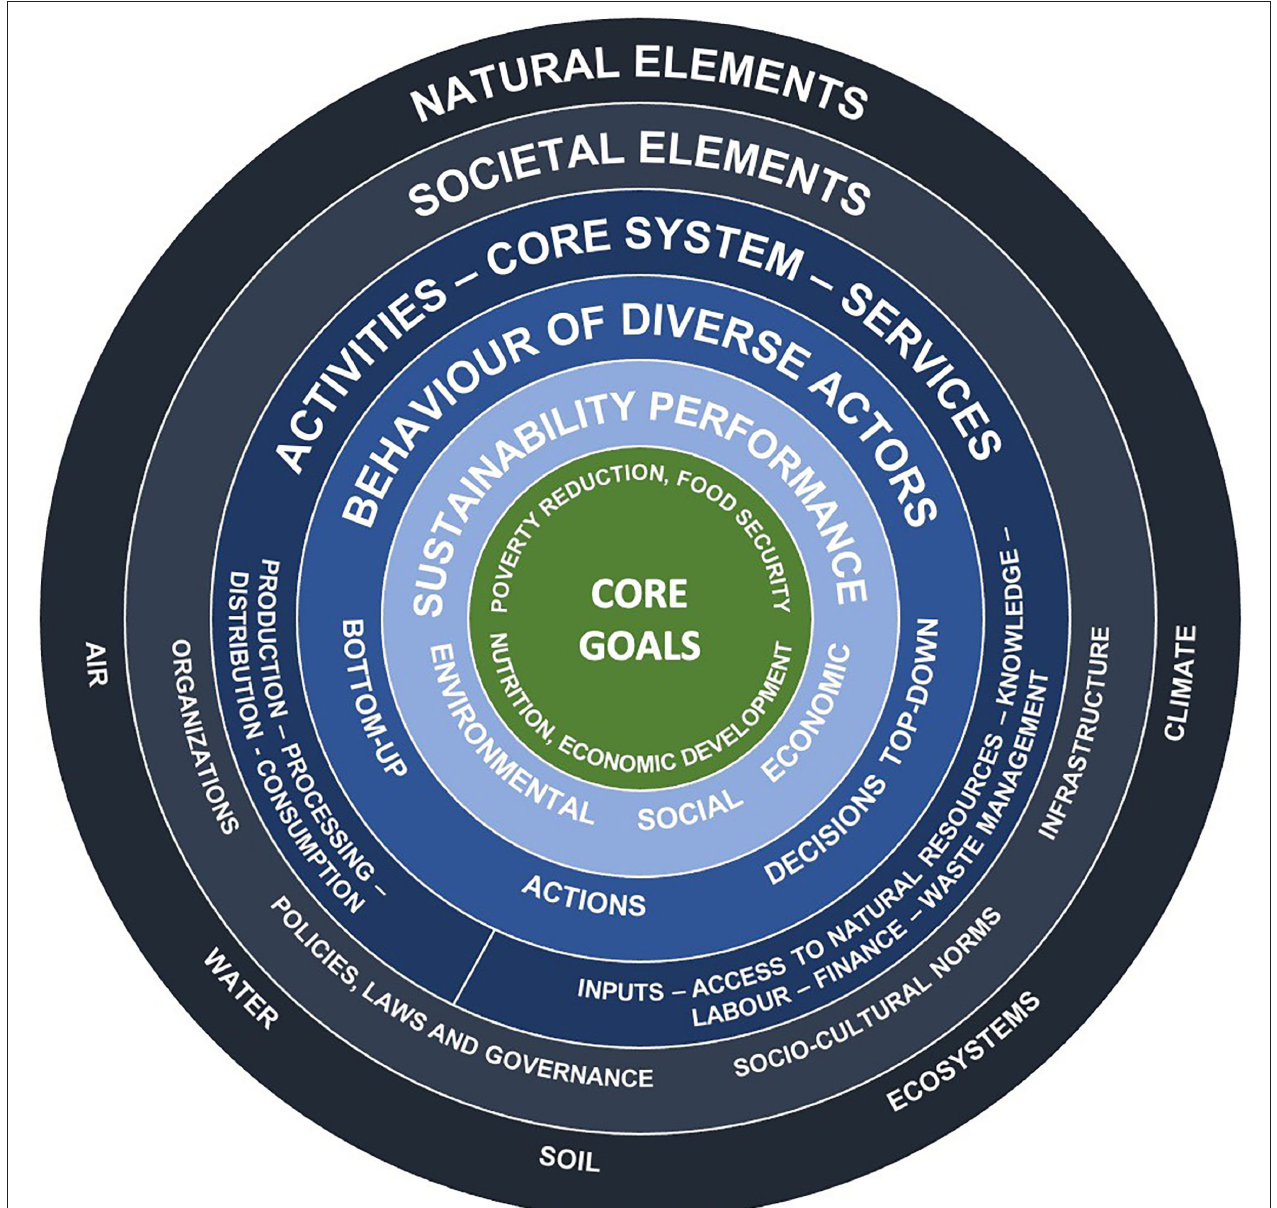
FIGURE 1 | Adapted Food Systems Framework. (Source: Food and Agriculture Organization of the United Nations. Adapted with permission).